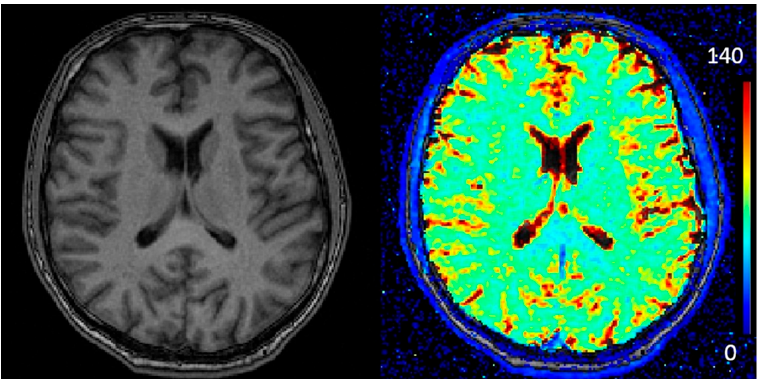
Figure 2. T1w image (left) and T2* (ms) parametric map (right) from a selected participant. Tomography 2021 , 7 , FOR PEER REVIEW Group-level activation maps by TE condition are displayed in Figure 3 (thresholded at p < 0.05, FWE-corrected, with minimum cluster size of 20 voxels). Use of a longer TE significantly improved beta values in all 6 ROIs ( p < 0.001), and resulted in higher number of active voxels in the left MI ( p = 0.002), SI ( p = 0.007), and bilateral SMA ( p = 0.003; Table 3).